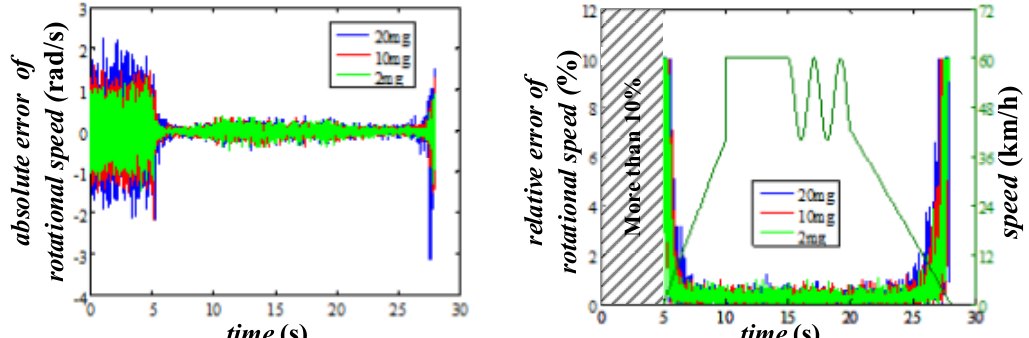
Figure 12. The evaluation error of rotational speed with different output noise.